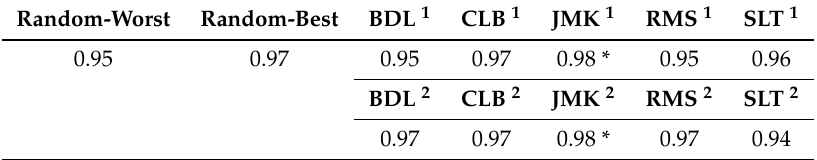
Table 7. Mean PESQ Results for SLT voice. Higher values represent better